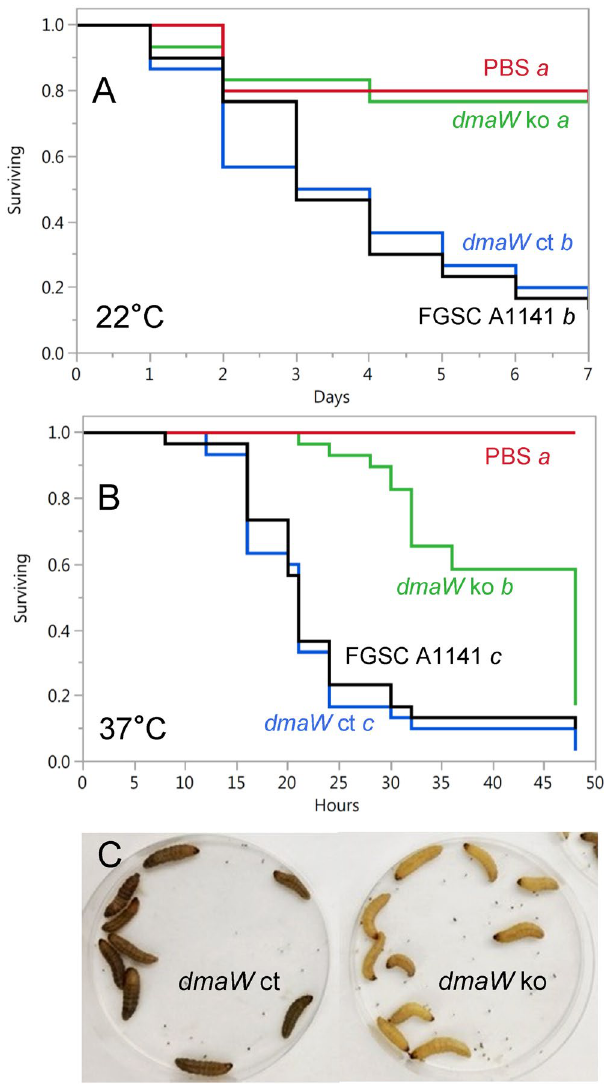
Figure 2. Survival curves for G. mellonella larvae injected with conidial suspensions of N. fumigata FGSC A1141, an ergot alkaloid-deficient dmaW knockout (ko) mutant of that strain, an ergot alkaloid restored strain complemented with a wild-type allele of dmaW ( dmaW ct), or phosphate-buffered saline control (PBS). In panel A, inoculated larvae were incubated at 22 °C for seven days. In panel B, inoculated larvae were incubated at 37 °C for 48 hours. Curves were derived from data from three trials with 10 larvae per treatment per trial. Treatment labels followed by different italicised letters have survival curves that differ significantly in a log-rank test with Bonferroni-adjusted alpha value set at 0.0083 (derived from 0.05/six pairwise comparisons). Panel C shows larvae incubated at 22 °C for 5 days in one